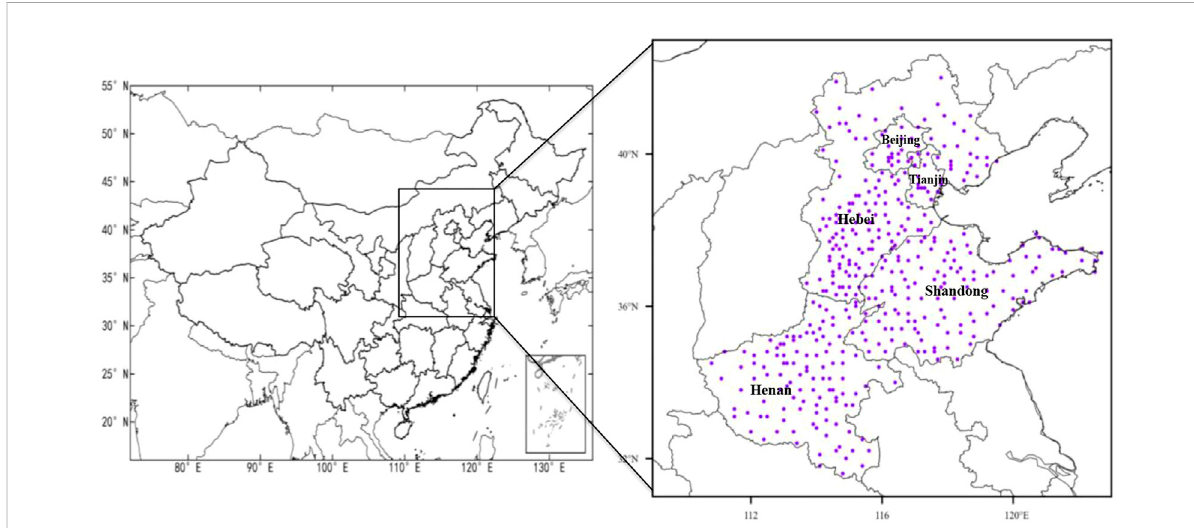
FIGURE 1 Locations of the meteorological stations in Beijing-Tianjin-Hebei (BTH) and its surrounding